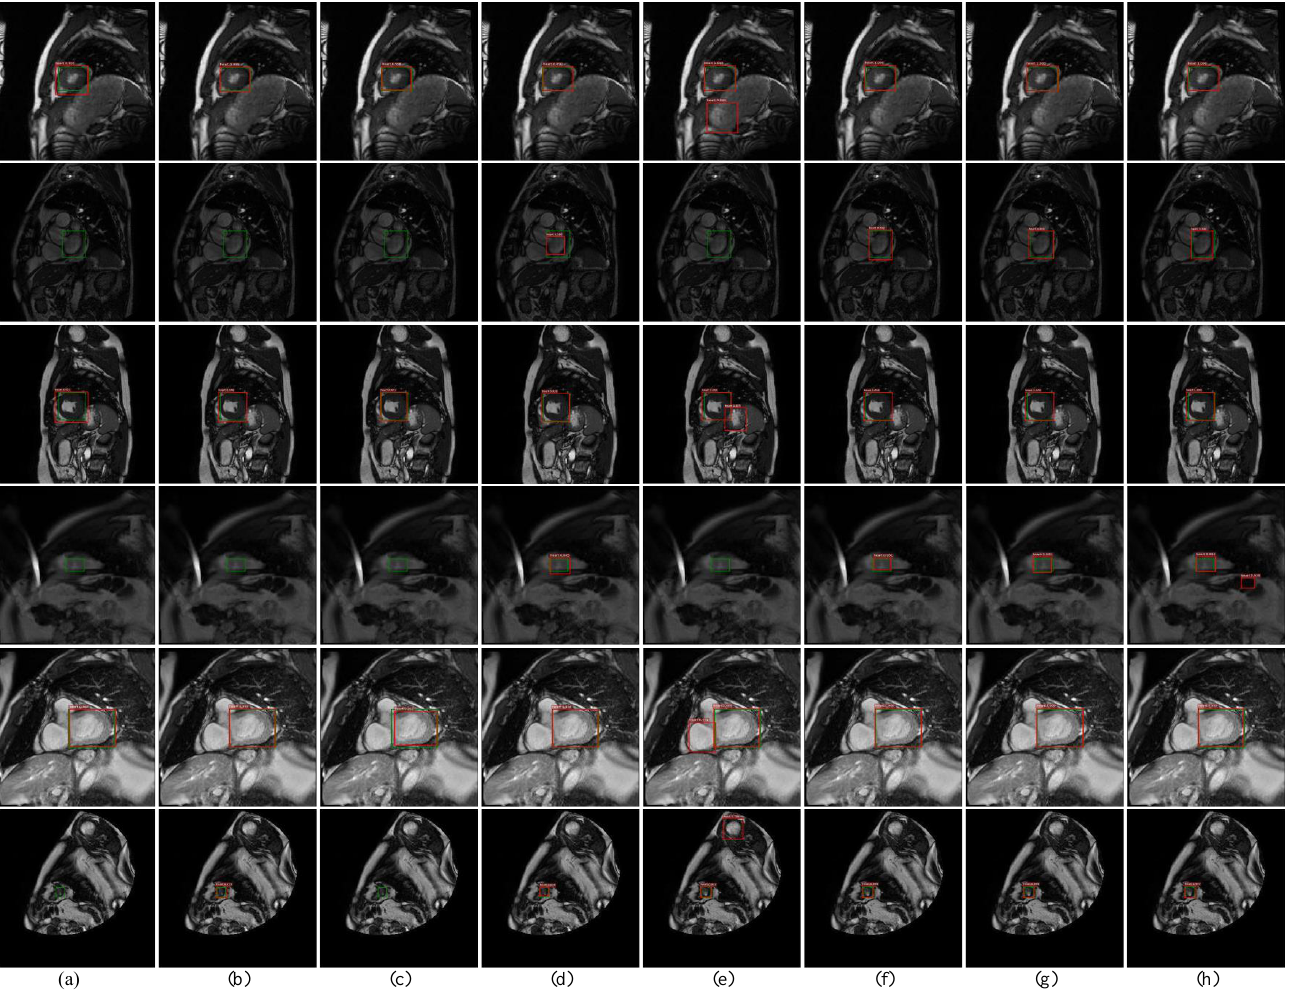
Figure 11. Detection examples by proposed methods and compared detection methods. ( a – h ) are SSD, Retinanet, Yolov3, Centernet, Faster RCNN, Correlation filter + Proposal, Discriminant dictionary + Faster, Correlation filter + Faster. The red box in the figure is the detection box, while the green box is the label